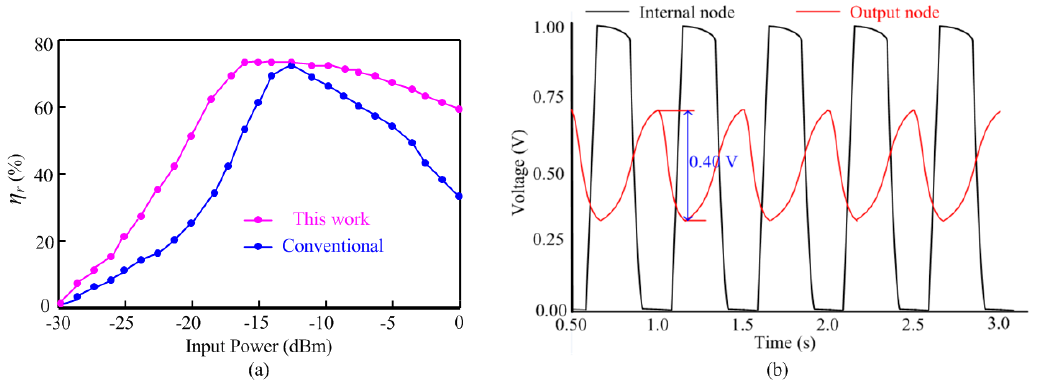
Figure 15. ( a ) Measured power conversion efficiency of the rectifier; ( b ) output waveforms of the proposed ring oscillator at different nodes.